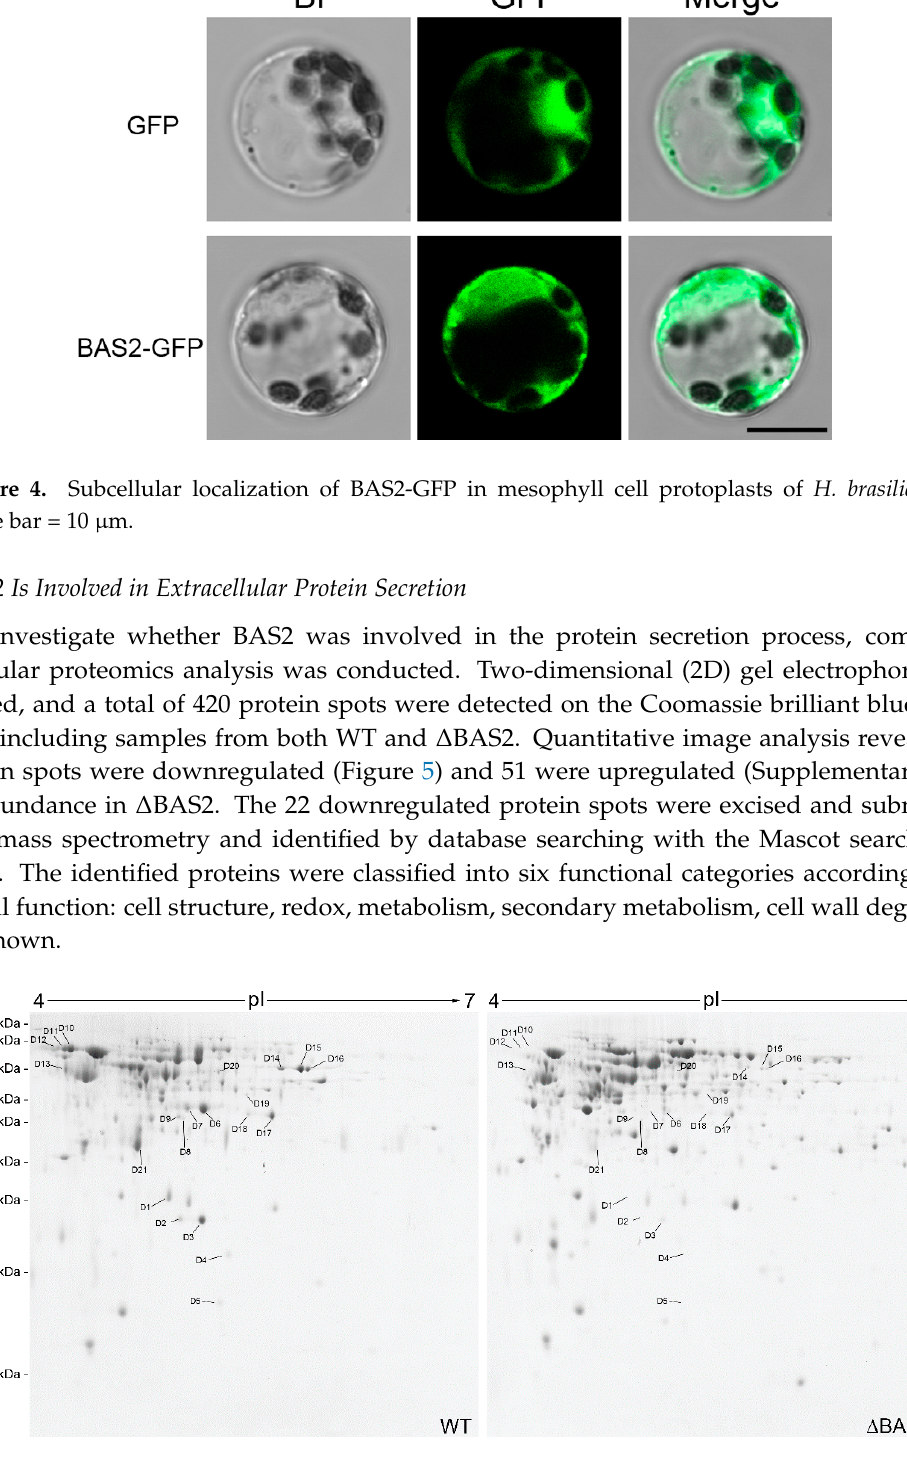
Table 1. Proteins identified by quadrupole-time-of-flight tandem mass spectrometry. The accession numbers of the proteins of C. gloeosporioides Nara gc5, which showed the most homology to the protein spots, are listed. NP, number of matched peptides; SC, amino acid sequence coverage for identified proteins; WT vs. Δ BAS2, average fold change of relative abundance of specific spot of WT versus Δ BAS2 from three biological repeats; ∞ , corresponding spot appeared in WT but not in Δ BAS2.